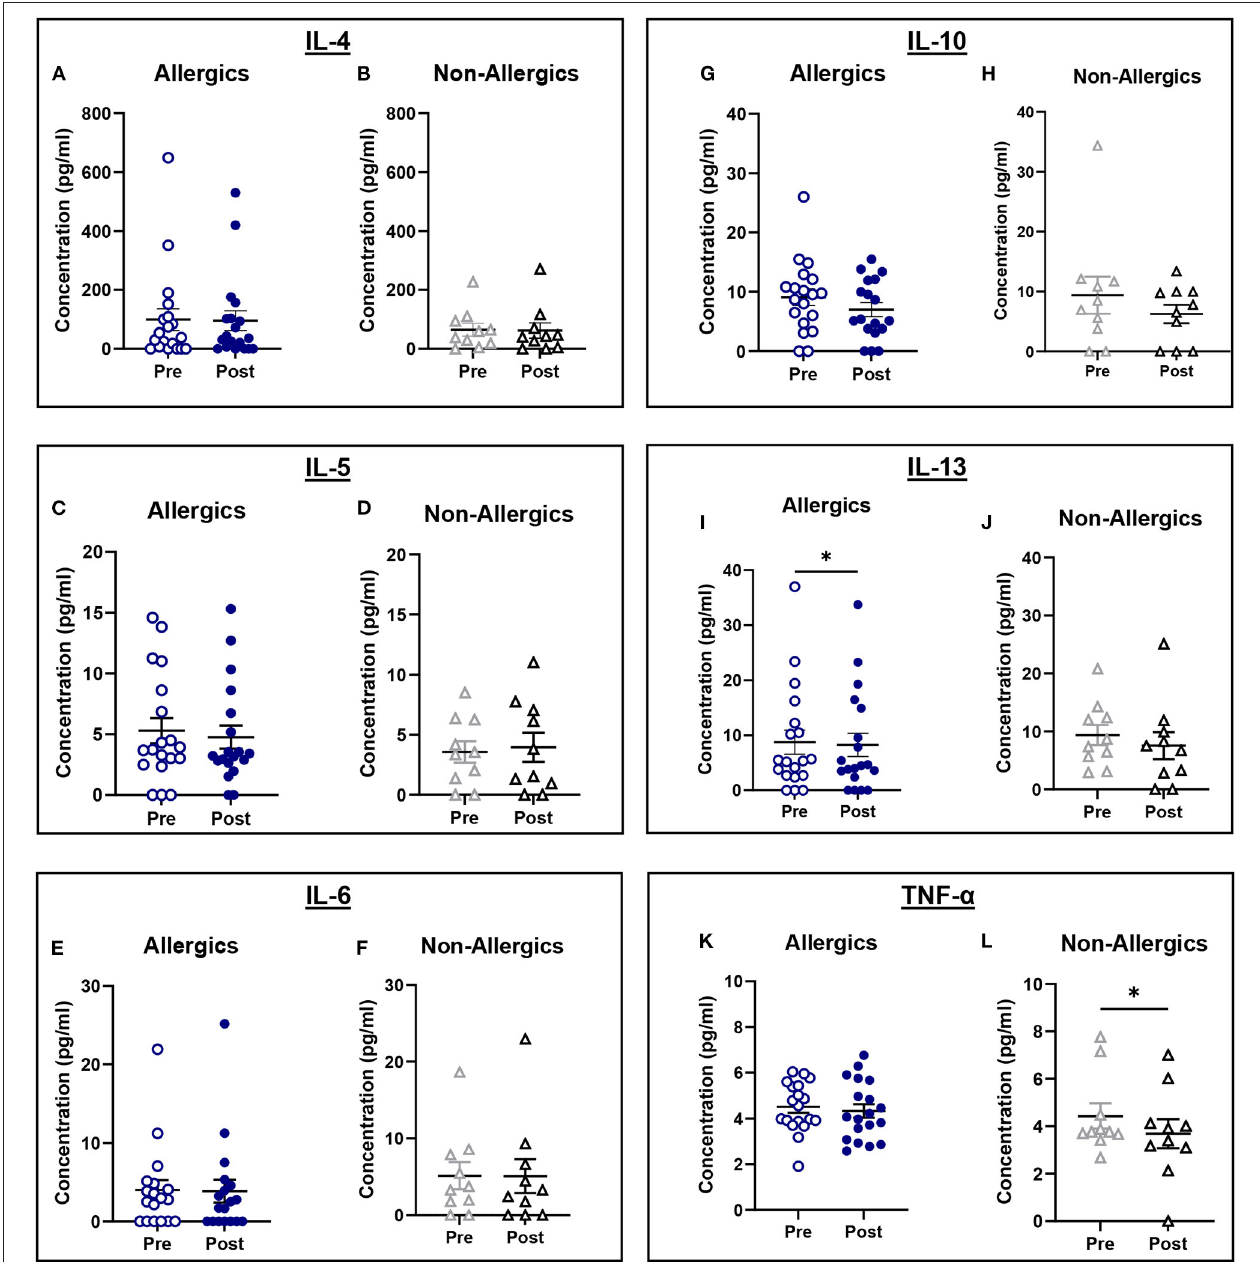
FIGURE 9 | Serum cytokine concentrations collected pre- and post-exposure for HDM-allergic and non-allergic participants. Concentrations of IL-4 (A,B) , IL-5 (C,D) , IL-6 (E,F) , IL-10 (G,H) , IL-13 (I,J) , and TNF- α (K,L) were evaluated pre- and post-HDM exposure for allergic and non-allergic participants in these paired analyses. IL-13 concentrations were significantly decreased only for HDM-allergic participants (I) , while TNF- α was significantly decreased in non-allergic participants. * , p < 0.05.